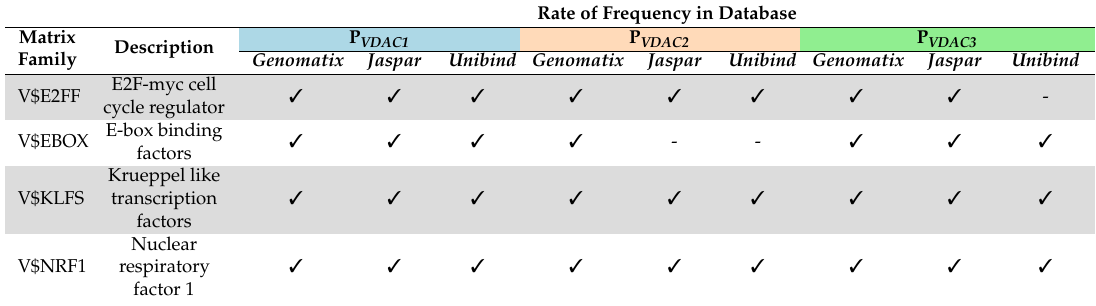
Table 1. Voltage-dependent anion-selective channels (VDACs) common Transcription Factor Binding Sites(TFBSs).Thesign (cid:51) indicatesthepresenceoftheTFBSinthepromoterselectedbyaspecificdatabase.